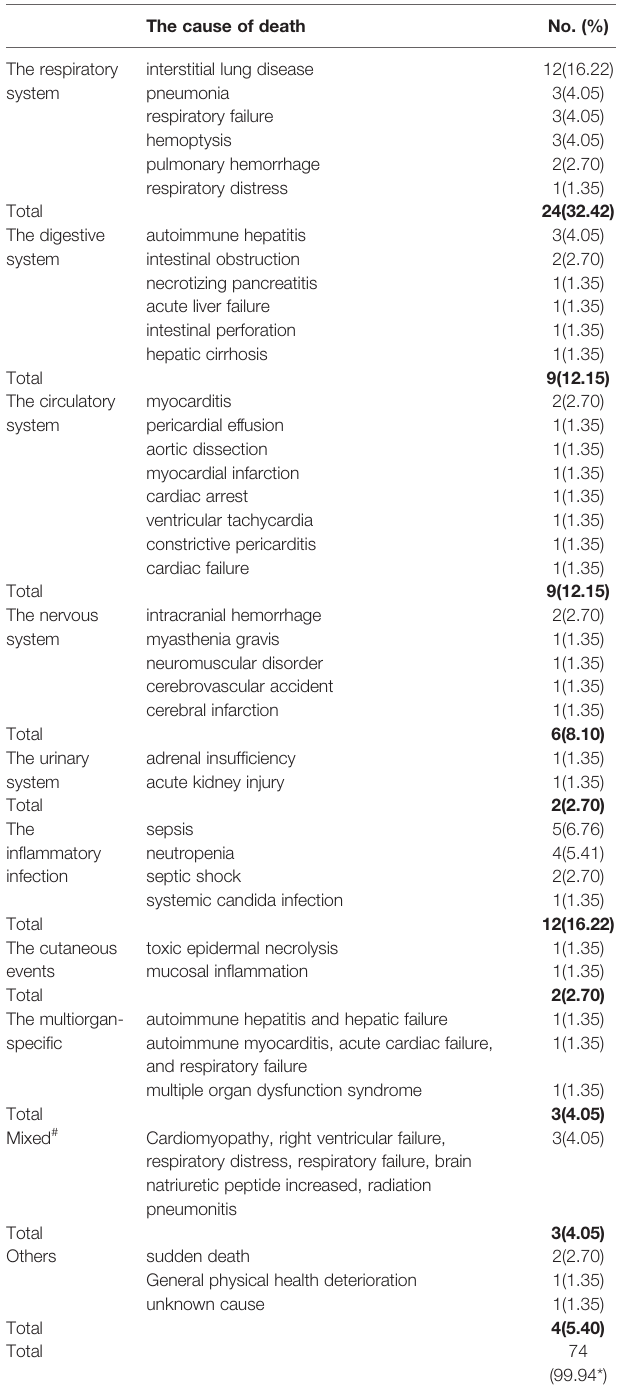
TABLE 4 | The spectrum of fatal adverse events associated with PD-L1 inhibitors. The cause of